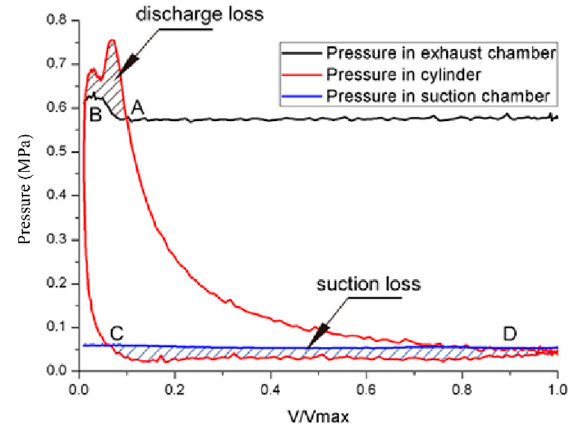
Figure 8. The flow loss through valve in p–V indicator diagram.